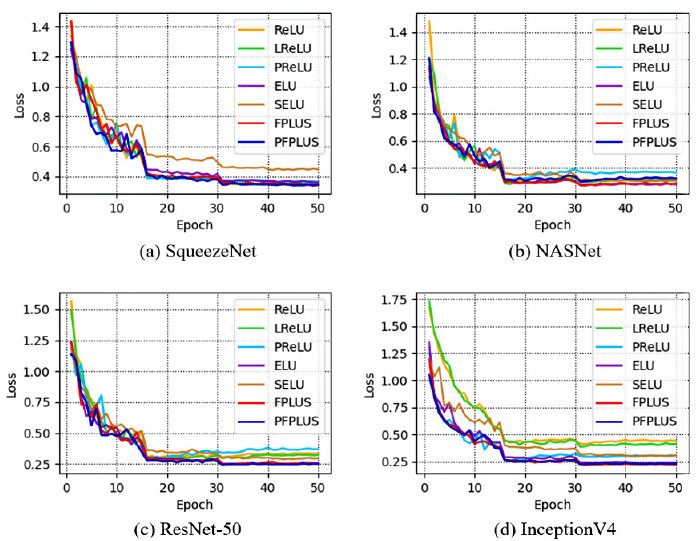
Figure 12. Curves of validating loss for each network applying diverse activation methods.